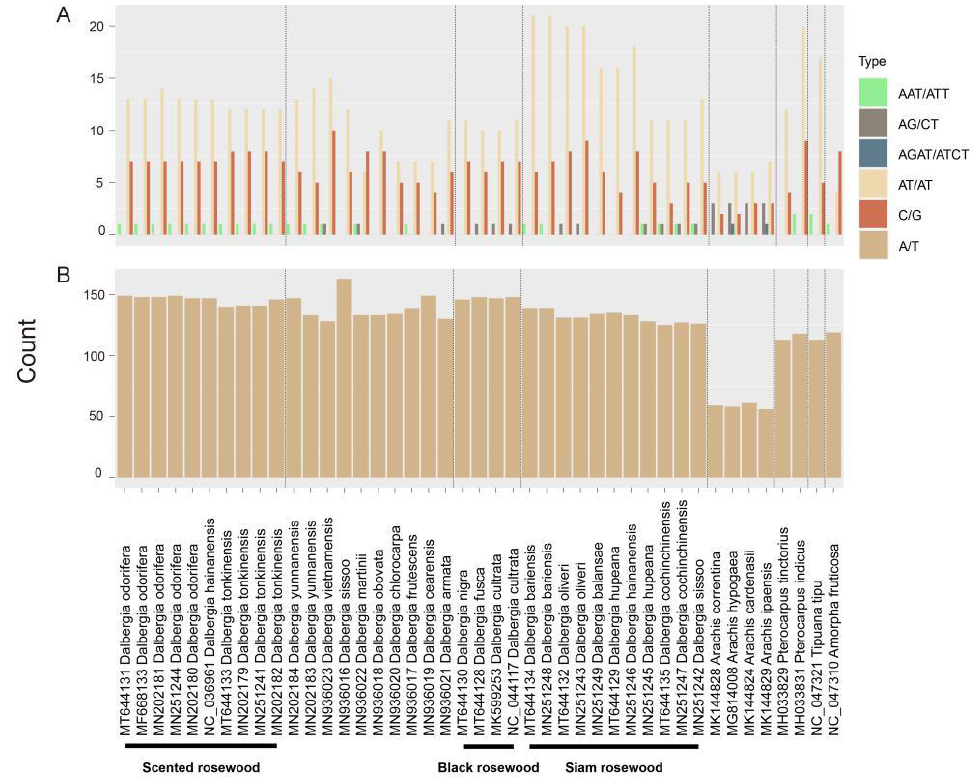
Figure 4. The number of simple sequence repeats (SSRs) of different types from 43 chloroplast genomes. ( A ) The number of AAT/ATT, AG/CT, AGAT/ATCT, AT/AT, C/G type SSRs; ( B ) The number of A/T type SSRs in each sample.